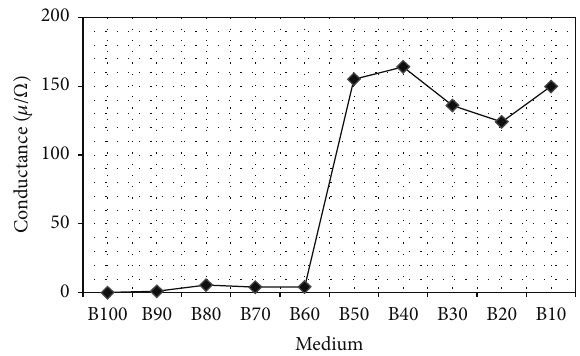
Figure 3: Emulsion inversion point of Pongamia